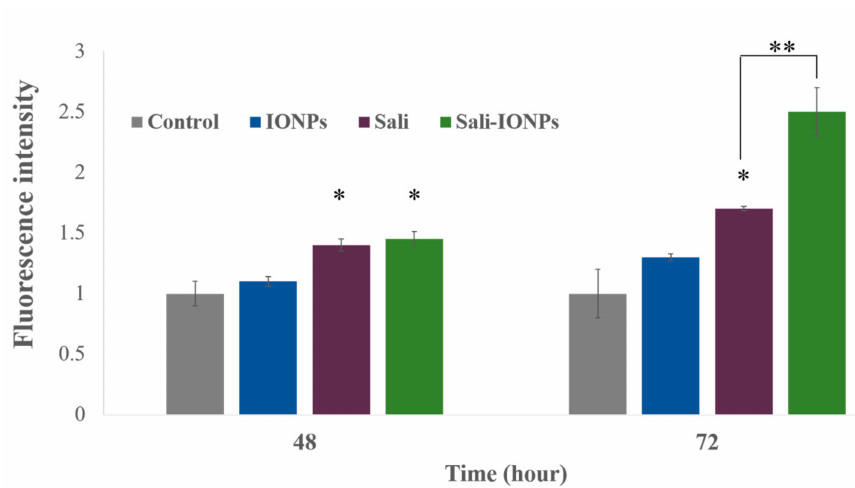
Figure 9. Reactive oxygen species (ROS) generation in U251 treated with either IONPs, salinomycin, or Sali-IONPs at di ff erent time-points. Note: * indicates a significant di ff erence compared to the control group at p < 0.05. Data was presented as mean ± SD; n = 5.